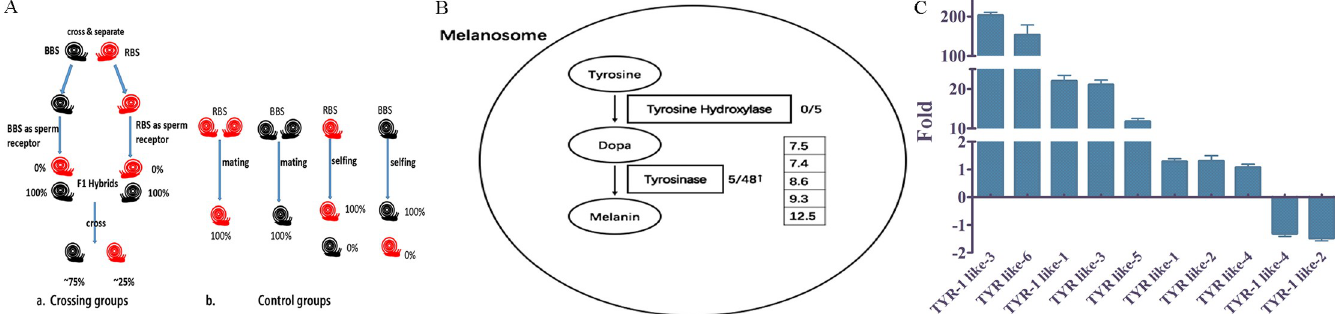
Fig 7. Phylogenetic relationship of B . straminea species collected from field. ( A ) Hybridization results of RBS and BBS. ( B ) Genes differentiated in melanin synthetic pathway of BBS comparing to F2RBS in transcriptomes, 0/5: 0 out of 5 tyrosine hydroxylase were up-regulated; 5/48: 5 out of 48 tyrosinase were up-regulated. Numbers in box behind represent the folds of up-regulation. ( C ) RT-PCR results of 10 different genes with tyrosinase (TYR) domain in BBS comparing to RBS.